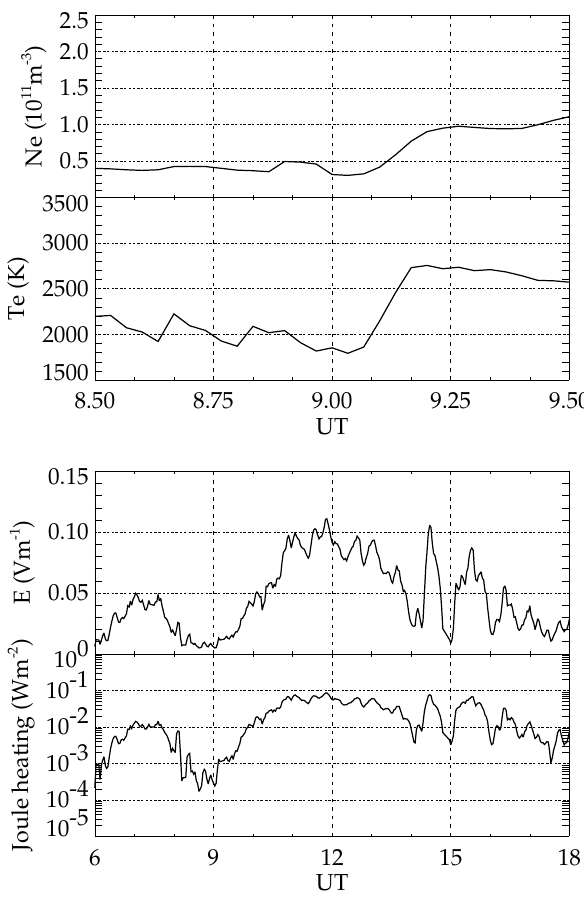
Fig. 2. The EISCAT measurements on 15 May 1997. The first and second panels show the electron density and temperature averaged between 350–600km during 08:30–09:30 UT. The third and fourth panels show the electric field and the Joule heating during 06:00– 18:00 UT. LT=UT+1h;